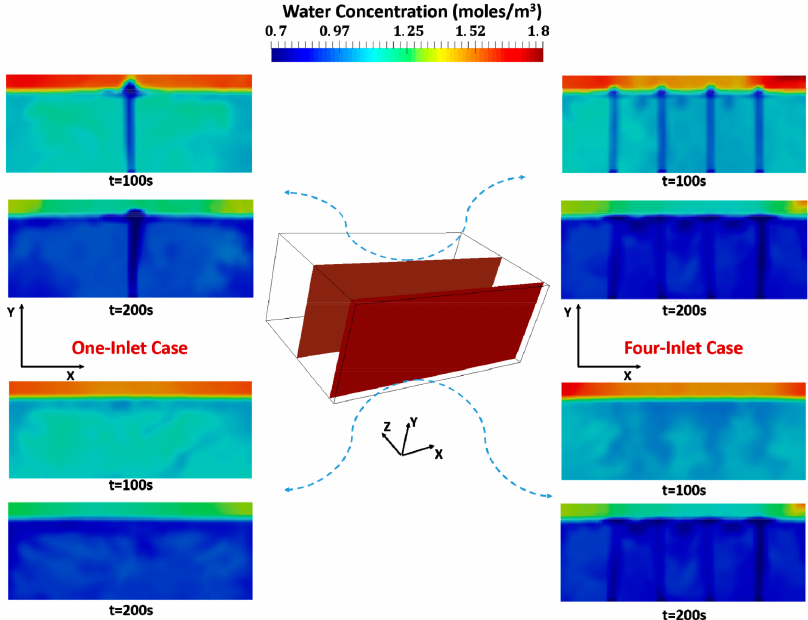
Figure 10. Molar concentration at two slices of the fuel tank at two different times. The bottom